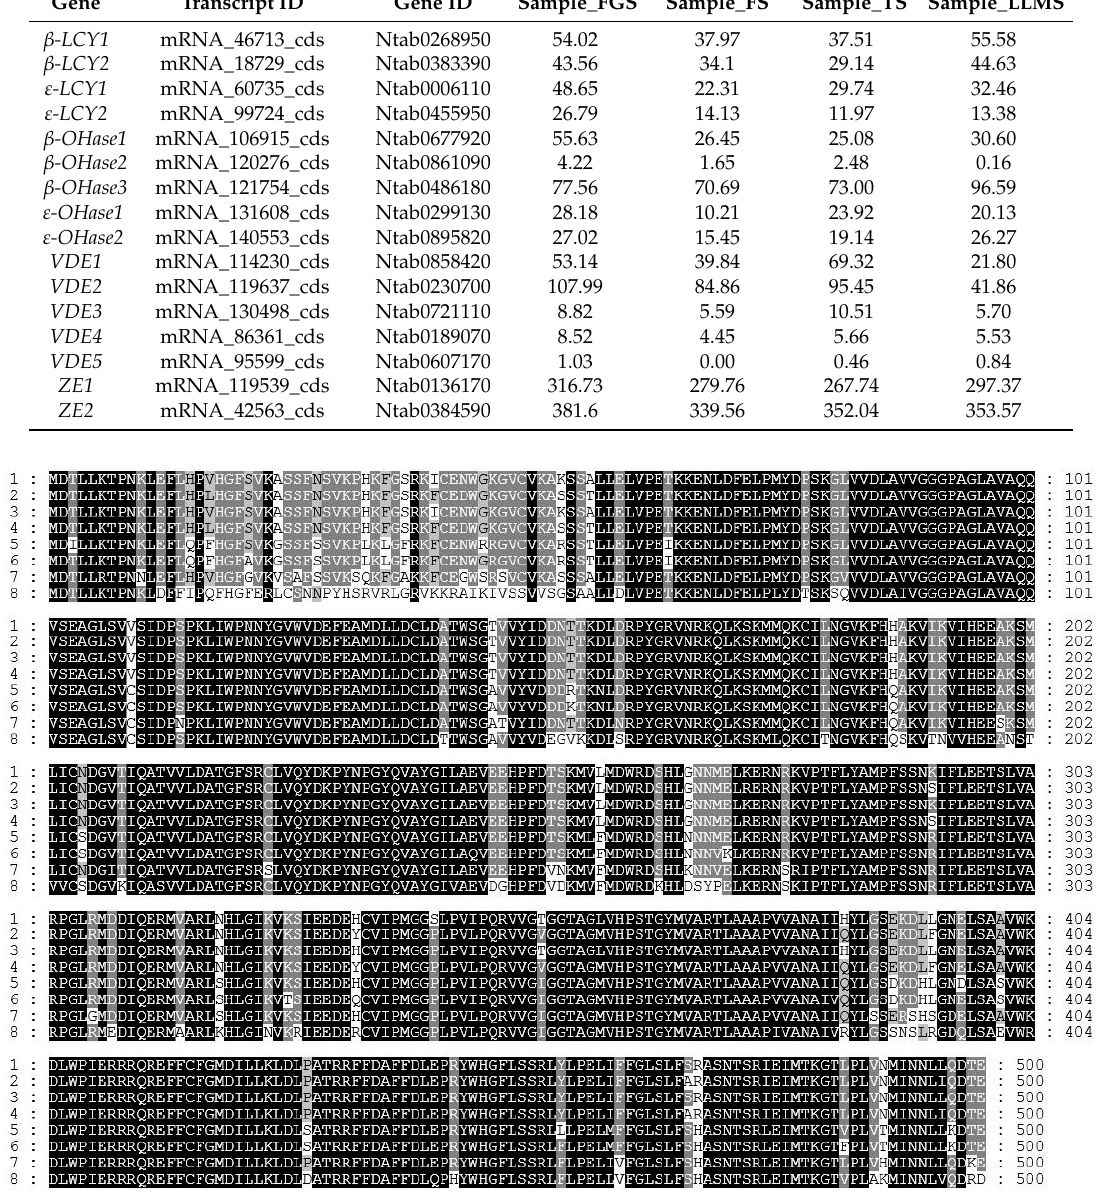
Figure 1. Comparison of β -LCY amino acid sequences by Genedoc software from Nicotiana tabacum